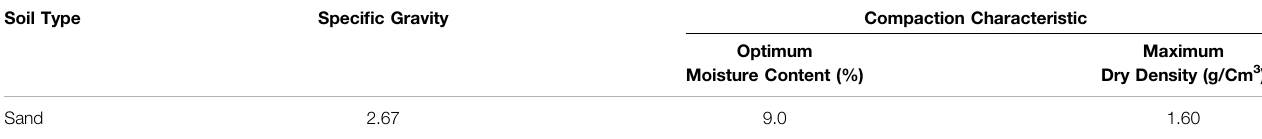
TABLE 1 | Physical properties of the test soils.